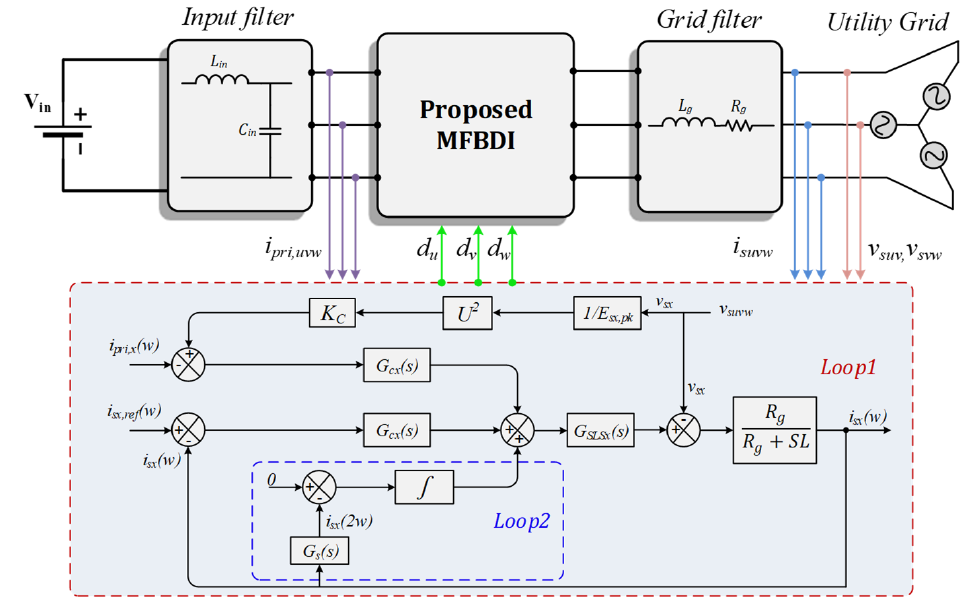
Figure 10. Control block diagram of the proposed MFBDI.